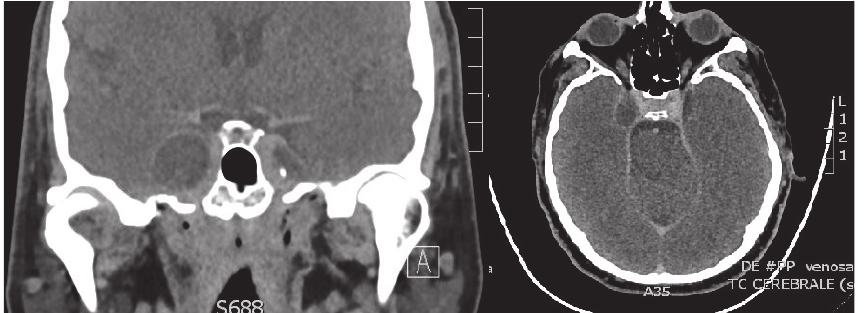
Figure 3: The CT venous phase shows that the cavernous sinus is compressed and medialized by the tumour rather than invaded by it.